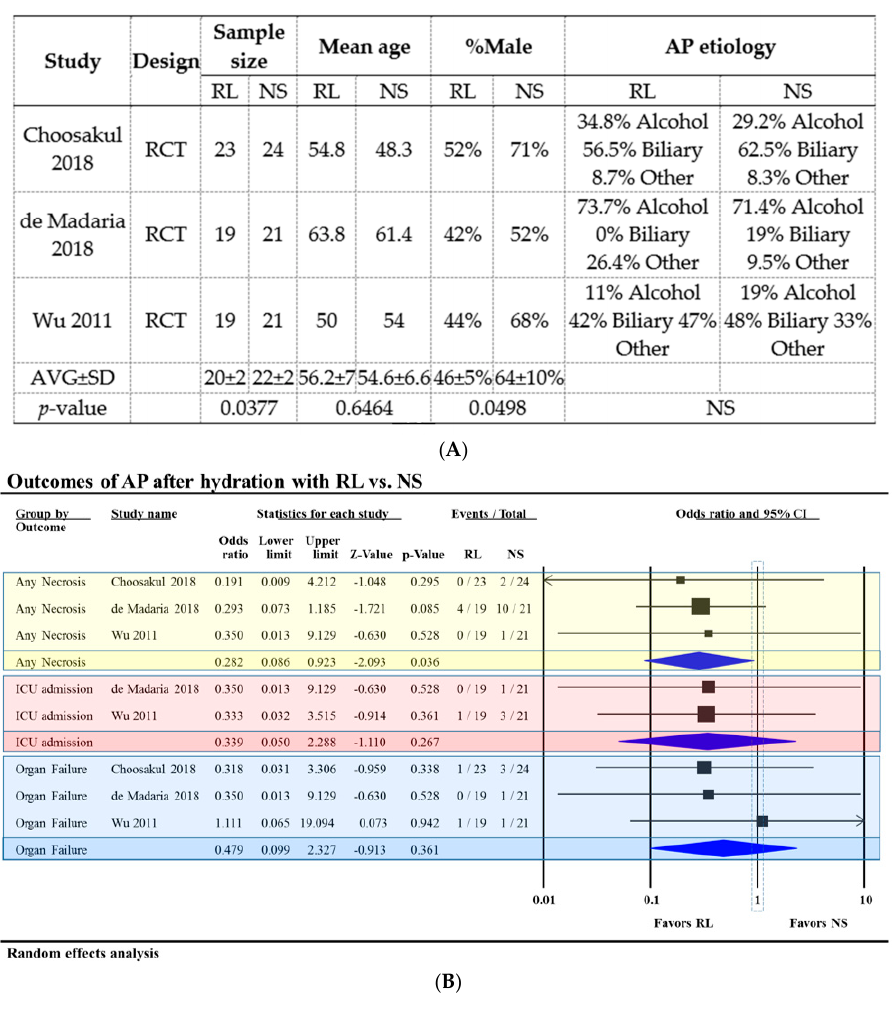
Figure 6. Meta-analysis of three randomized controlled trials comparing Ringer’s lactate to normal saline. ( A ) Study characteristics of those included in the meta-analysis. RL: Ringer’s lactate. NS: Normal Saline. AP: Acute pancreatitis. AVG: Average. SD: Standard deviation. NS: Not significant. ( B ) Outcomes of acute pancreatitis after hydration with Ringer’s lactate vs. normal saline. AP: Acute pancreatitis. RL: Ringer’s lactate NS: Normal Saline.